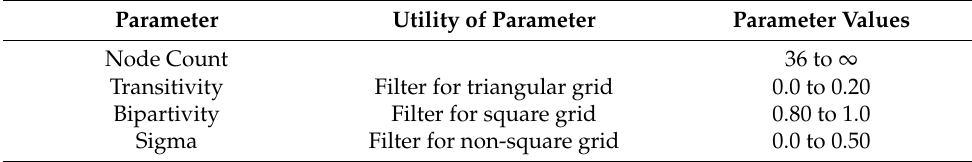
Table 3. Parameter values for an idealized square grid network